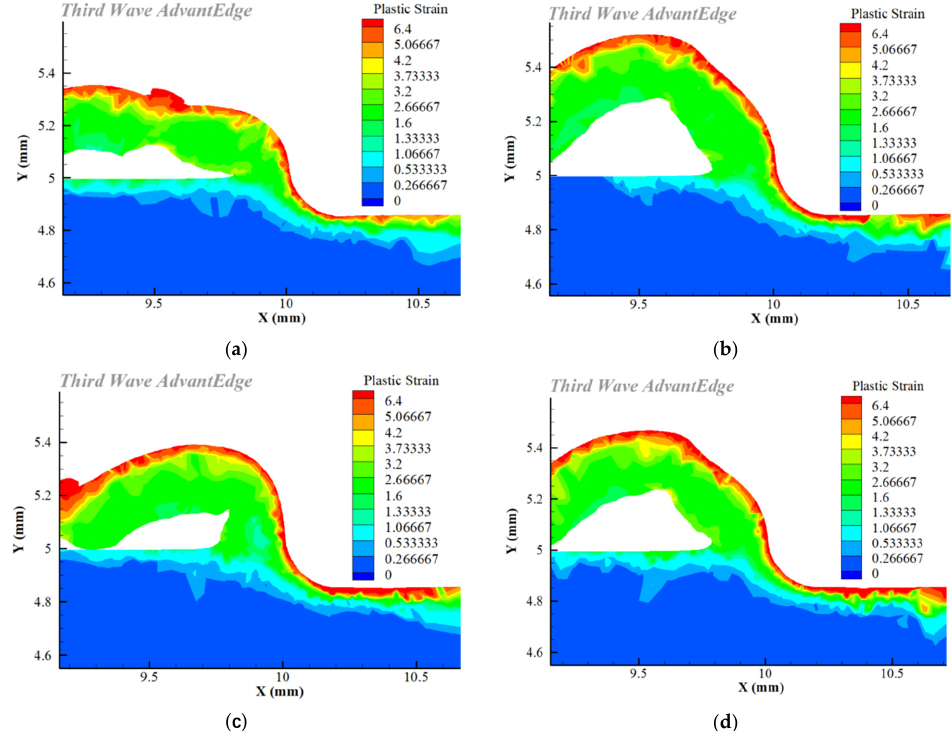
Figure 5. Simulation results for plastic strain: ( a ) VB = 0 mm; ( b ) VB = 0.1 mm; ( c ) VB = 0.2 mm; ( d ) VB = 0.3 mm.